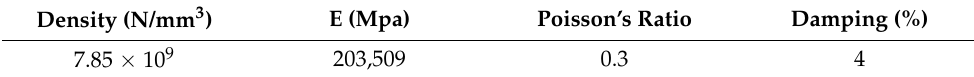
Table 3. Boundary condition of the piping system. Table 4. Material properties of the piping system.